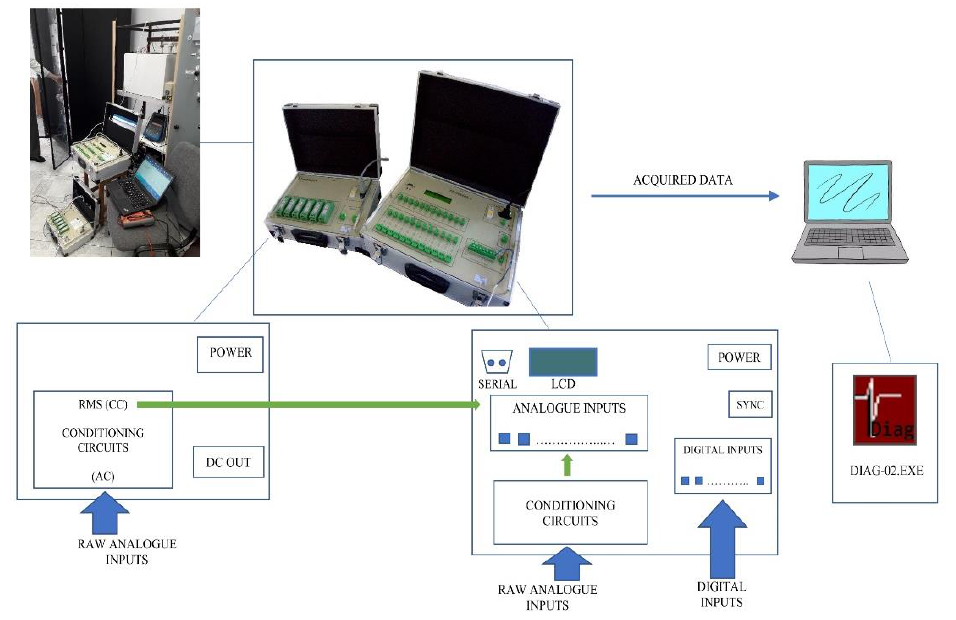
Figure 2. DIAG-02: Dataflow and installation example.